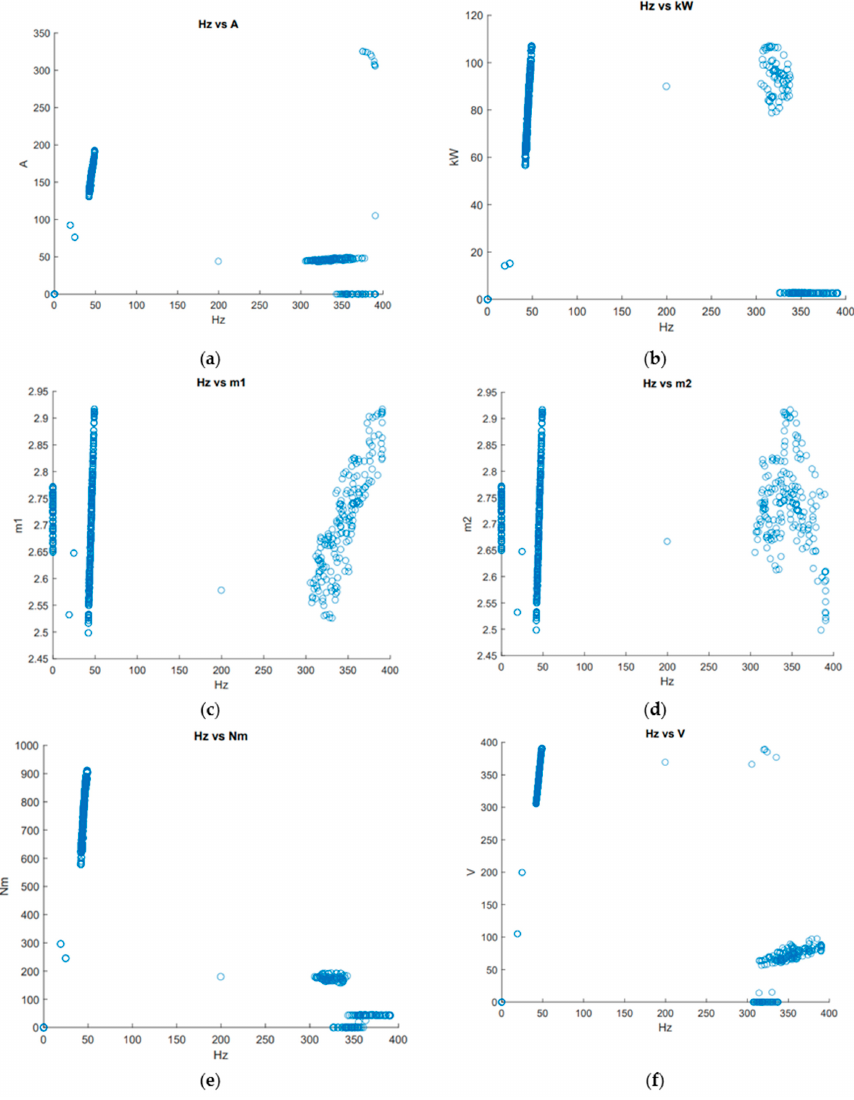
Figure 5. Data on pump operation: ( a ) current (A), ( b ) power (kW), ( c ) sewage level in Chamber A (m1), ( d ) sewage level in Chamber B (m2), ( e ) torque (Nm), and ( f ) voltage (V) depending on frequency (Hz).